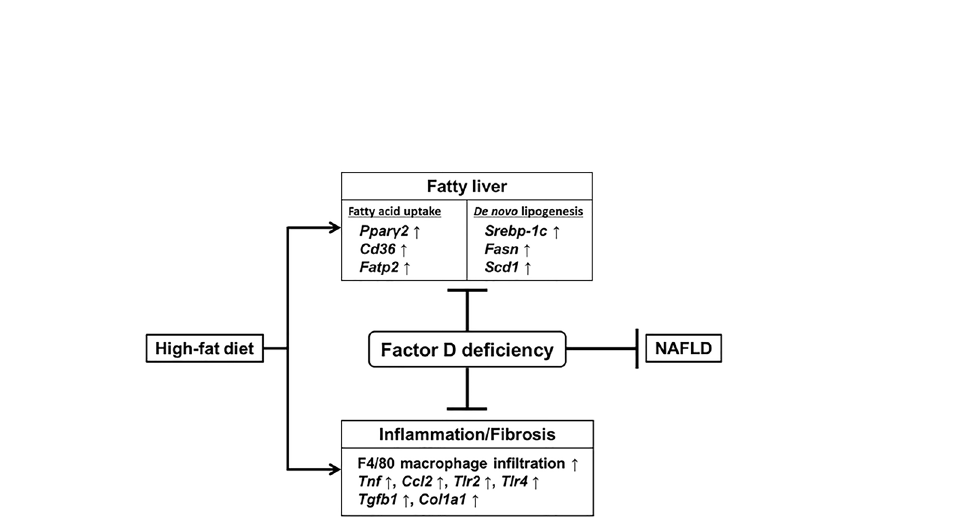
Figure 6. Scheme of the mechanism of suppression of hepatic lipid accumulation and inflammation by Factor D deficiency in mouse. Deficiency of Factor D increased by HFD-feeding reduced hepatic lipid accumulation and inflammatory factors in the